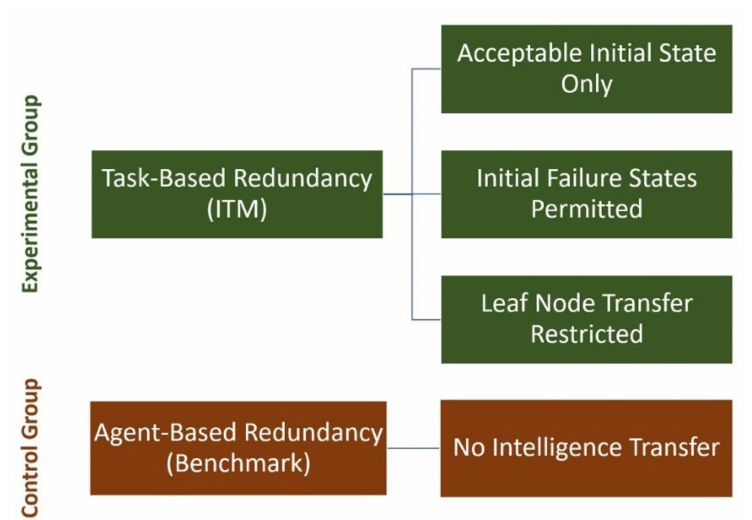
Figure 28. Selection of the experimental and benchmark/control MAS configurations classified as either task-based or agent-based